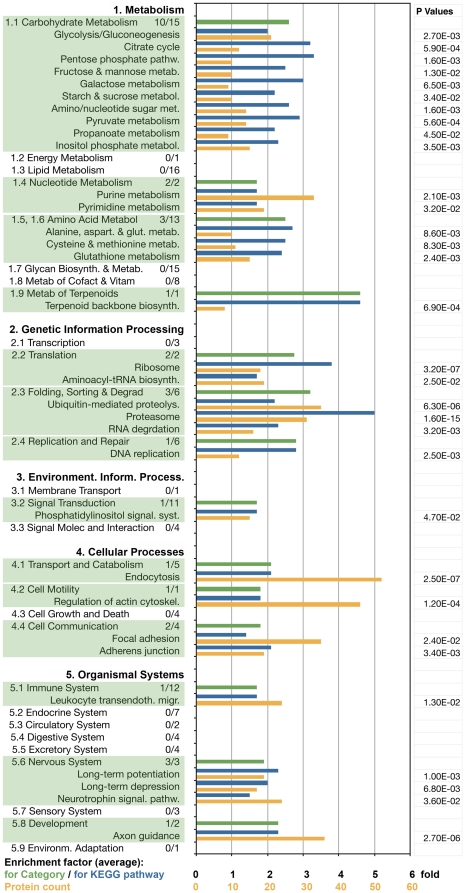
KEGG pathways in axonal growth cones.The five relevant KEGG pathway categories and their subcategories (enriched subcategories are shaded) are listed on the left. The numbers following each subcategory title indicate the number of pathways detected in GCPs/total number of identified pathways in mammals. Bars indicate the average enrichment factor for the subcategory (green), the enrichment factor for each pathway (blue), and the number of protein species of the pathway detected in GCPs (ochre). P values (<0.05) are shown on the right.